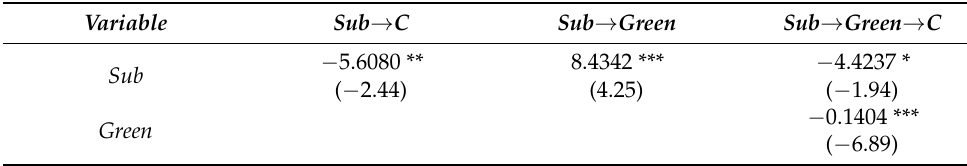
Table 6. Regression results for the role of green-technology